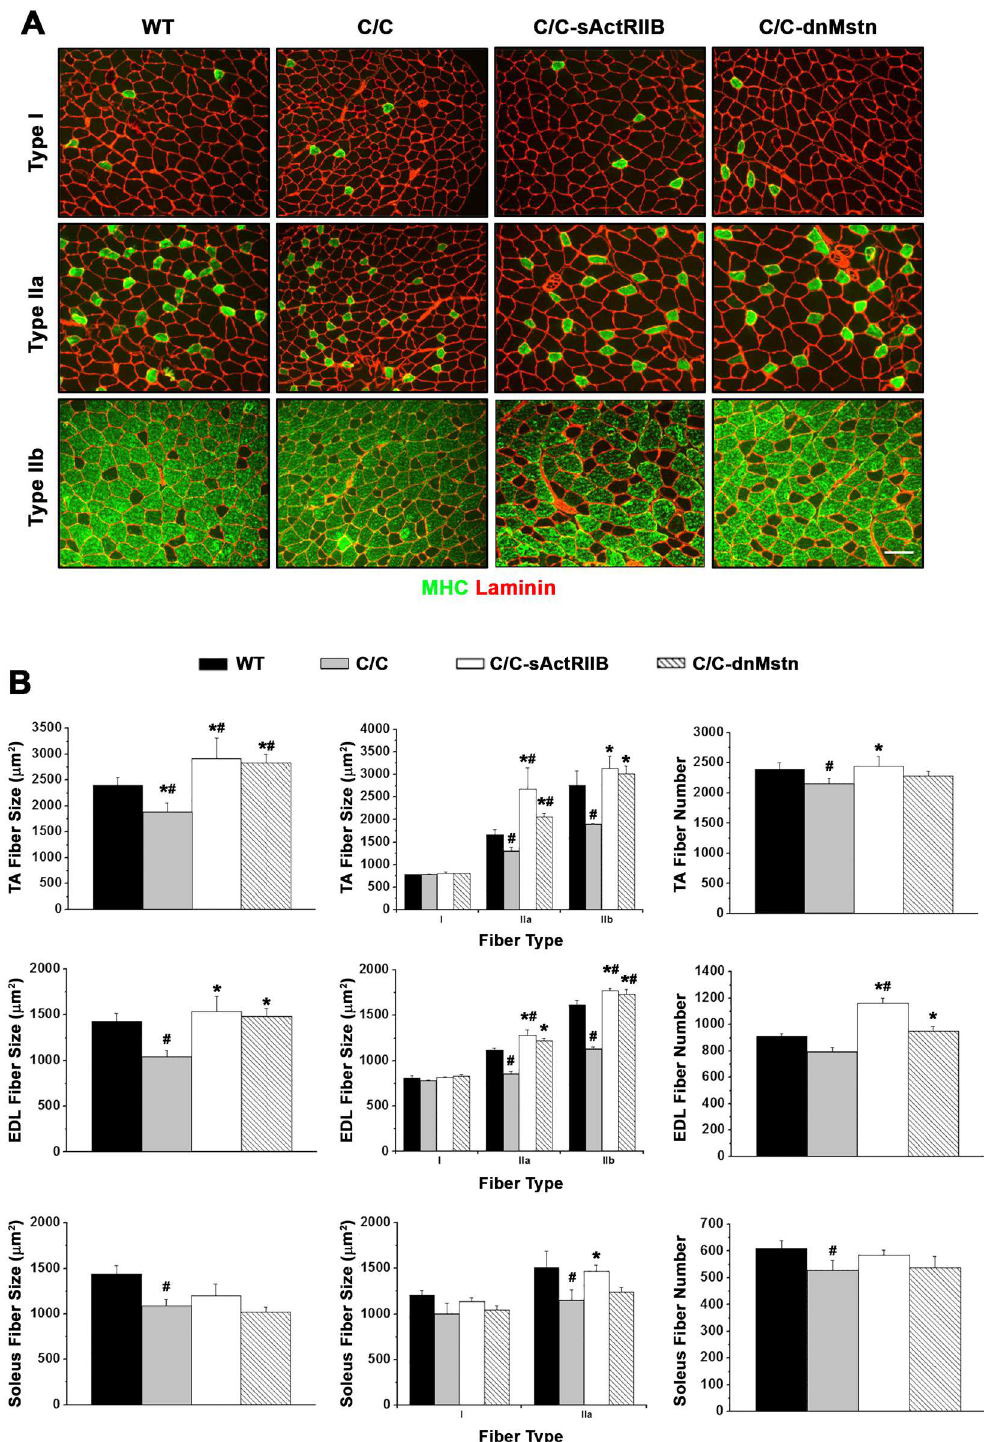
Fig 4. Fast twitch muscle fiber size of SMA C/C mice rescued by activin inhibition. ( A ) Representative tibialis anterior (TA) muscle cross-sections stainedwith anti-myosin heavy chain (MHC) isoform and anti-lamininfor fiber- typing and area analysis. Scale bar indicates100 μ m.( B ) Total muscle fiber size (left), muscle fiber size by fiber type (middle)and total muscle fibers (right) from the TA, extensor digitorumlongus (EDL), and soleus muscles from 12 week-oldwild-type (WT; n = 6) and SMA C/C mice from control (C/C; n = 6), AAV8.LSP.sActRIIB